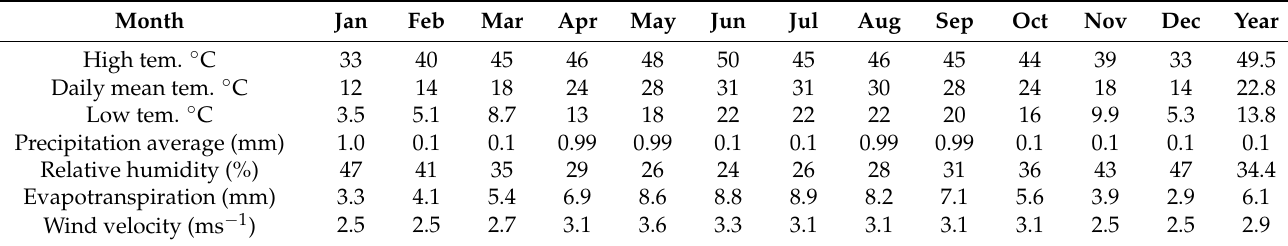
Figure 1. Location map of the study area relative to Egypt map. Table 1. Climatic data for Dakhla Oasis.